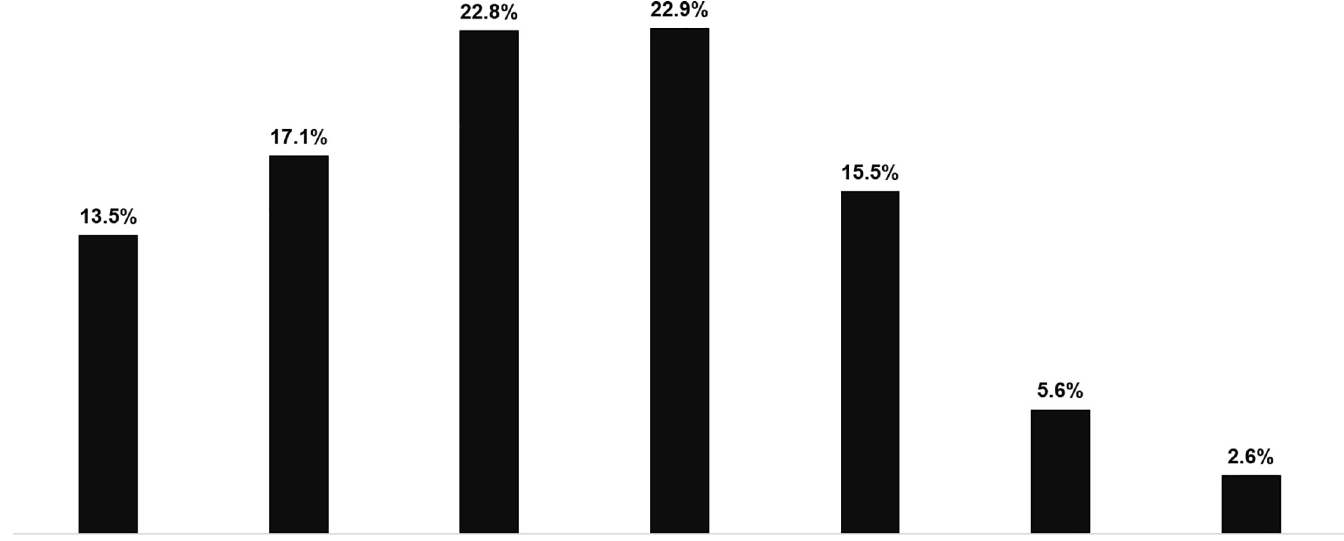
Fig 3. Percentages of respondents who gave correct